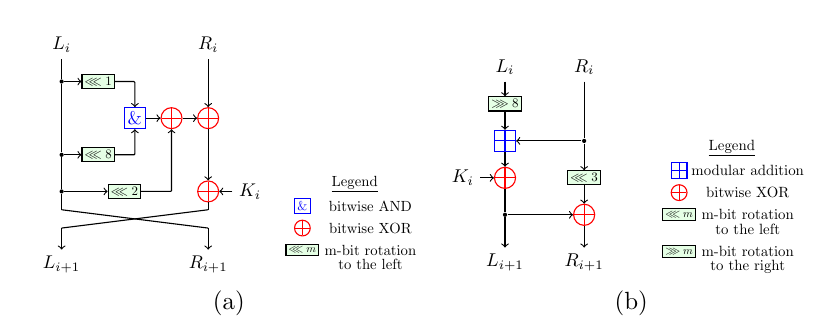
Figure 3: Schematic of one round of (a) SIMON and (b) SPECK block cipher.